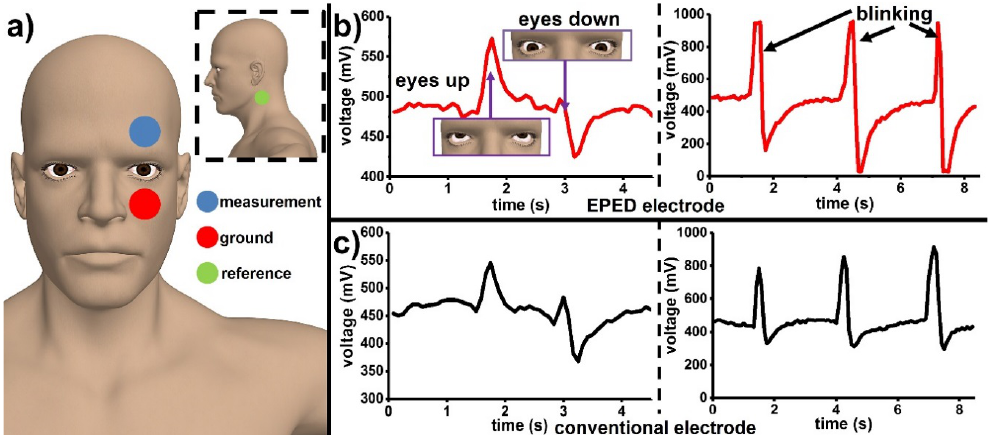
Figure 5. Monitoring eye motion using razor printed EPEDs: ( a ) Location of the measuring, ground, and reference copper-based EPED electrodes; ( b ) Left: EOG signal identifying eye movements (up and down) using EPEDs; Right: Identification of blinking events using EPEDs; ( c ) Left: Identification of eye movements (up and down) using conventional foam electrodes located as shown in ( a ); Right: Identification of blinking events using conventional foam electrodes.